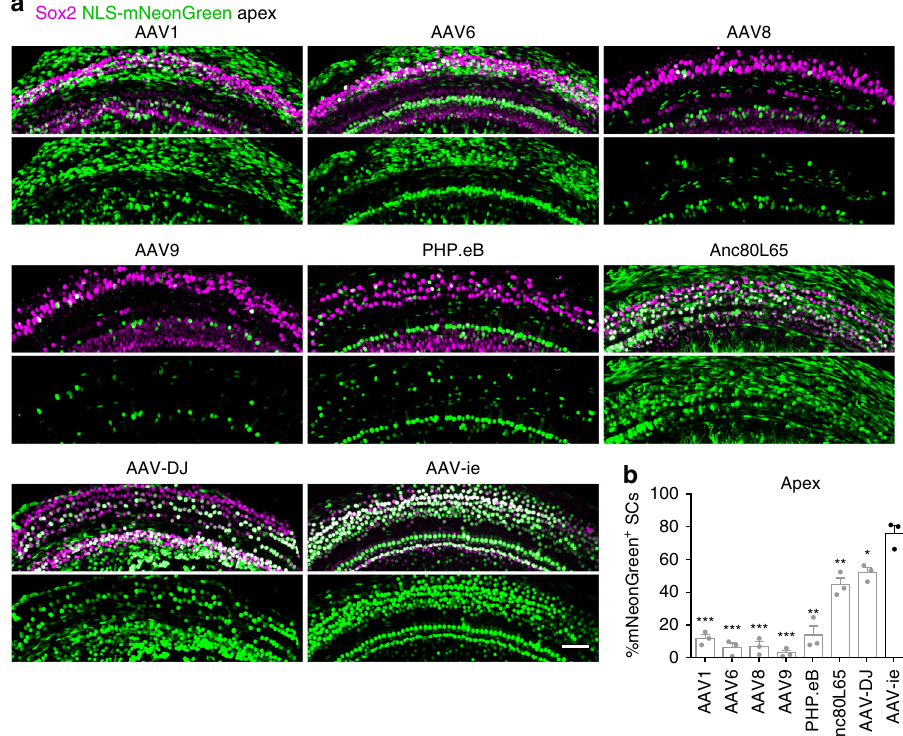
Fig. 1 Adeno-associated virus-inner ear (AAV-ie) infects cochlear supporting cells with high ef fi ciency. a Representative images of nuclear localization sequence-mNeonGreen (NLS-mNeonGreen) fl uorescence (green) and Sox2 staining (magenta) in the apical turns of cochleae infected with different AAVs serotypes at the same dose (3.6 × 10 9 genome-containing (particles) (GCs) per ear). Cochleae were harvested at P14 after microinjection with 1.5 µ L of AAV stock solution in one ear at P3. mNeonGreen, a green fl uorescent protein. Sox2, a marker for supporting cells. Scale bar, 50 µ m. b Percentage of NLS-mNeonGreen-positive supporting cells per 100 µ m corresponding to a . Data are shown as mean ± SEM. Signi fi cance tests were performed between AAV-ie and other AAV serotypes (see Methods). p Value is calculated by Student ’ s t test. * p < 0.05, ** p < 0.01, and *** p < 0.001. N = 3 mice. Source data are provided as a Source Data fi